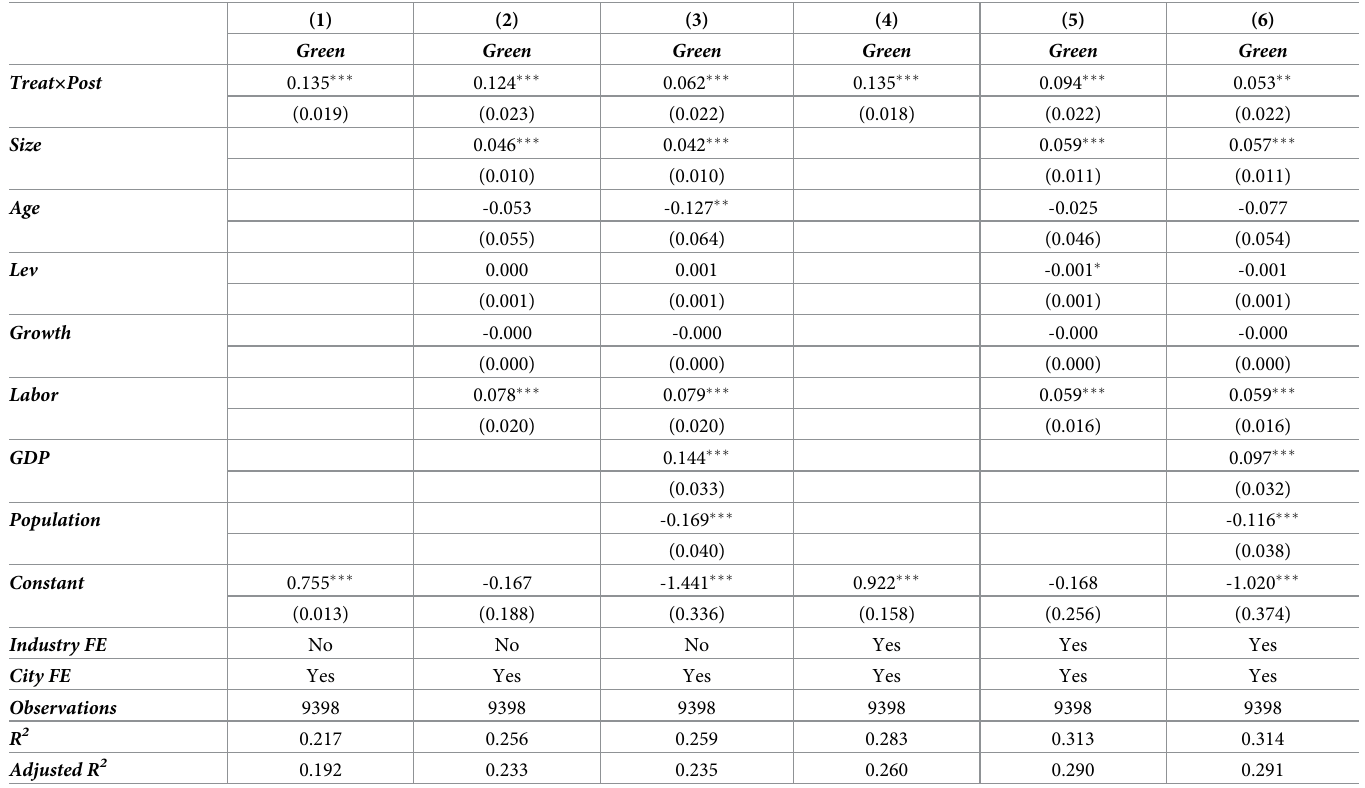
Table 4. Basic regression